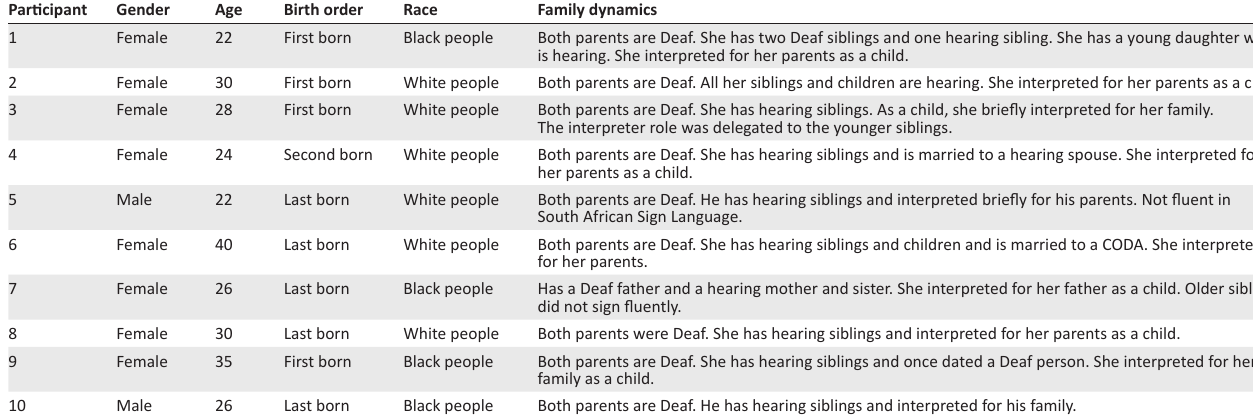
TABLE 1: Demographic profile of